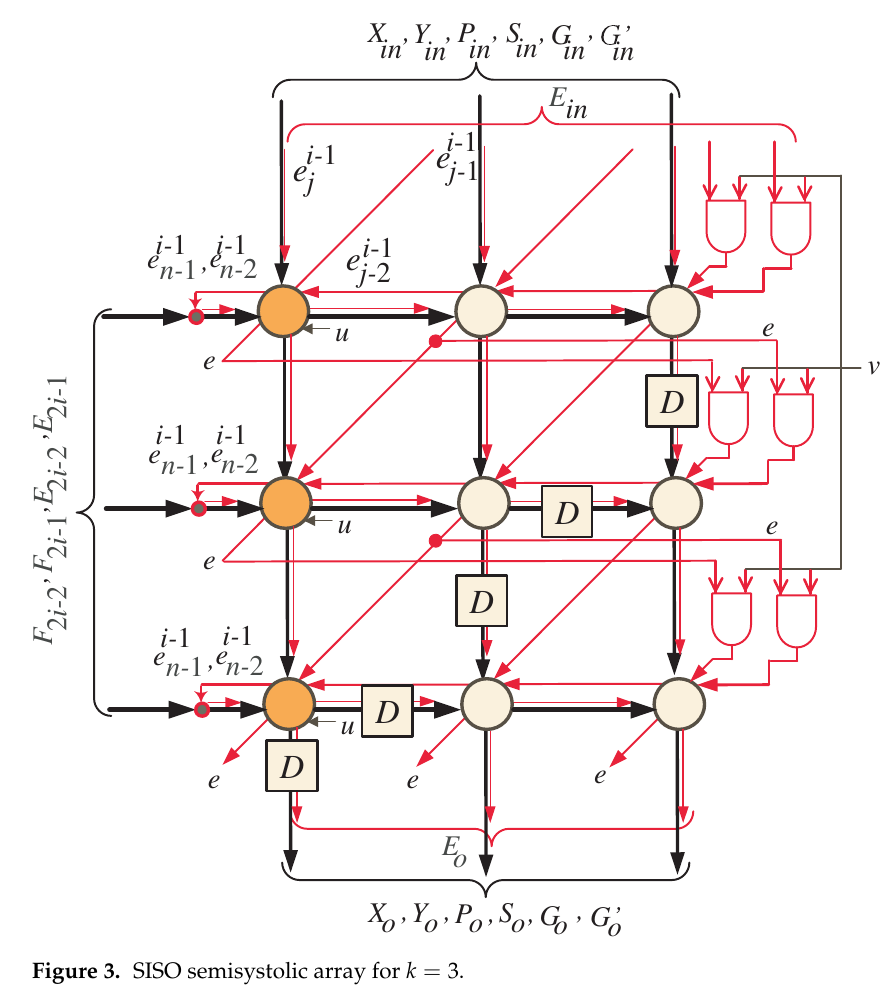
Figure 3. SISO semisystolic array for k = 3.